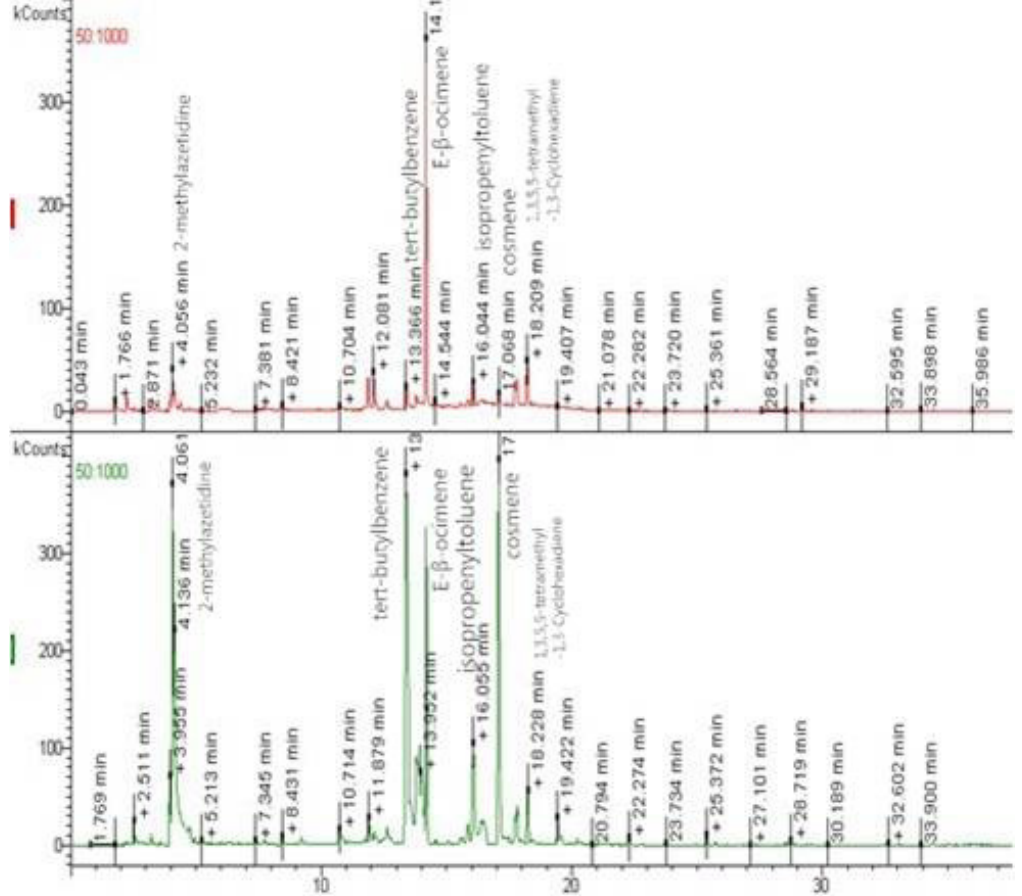
Fig 2 . Gas chromatography–mass spectrometry (GCMS) total ion chromatography of healthy and diseasedhoney bee, Apis mellifera , broods by solid phase microextraction (SPME) method. A: GCMS total ion chromatography of healthy brood by SPME method. B: GCMS total ion chromatography of diseased brood by SPME